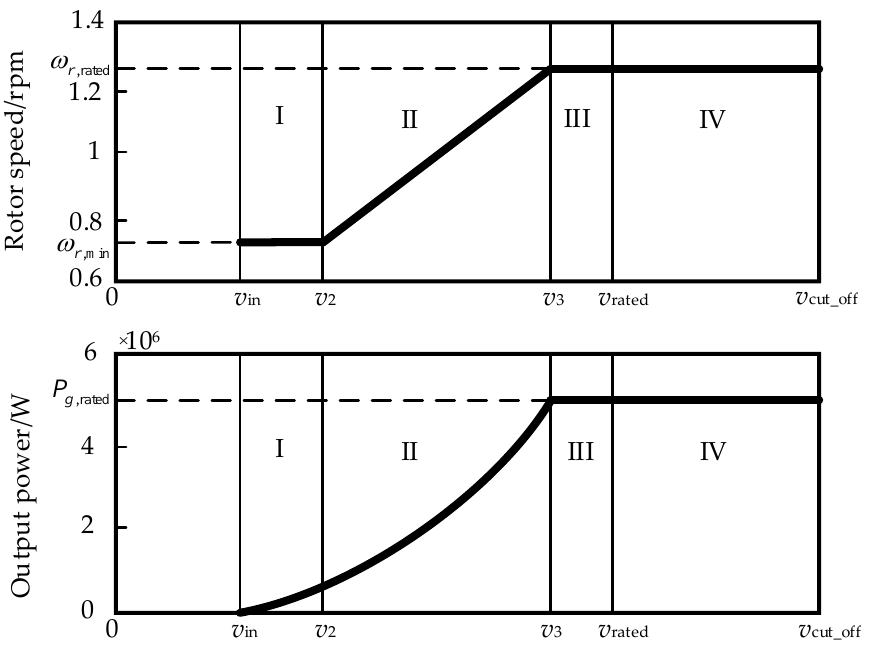
Figure 1. Optimal steady-state targets of the rotor speed ω r and electric power P g in different operating regions.